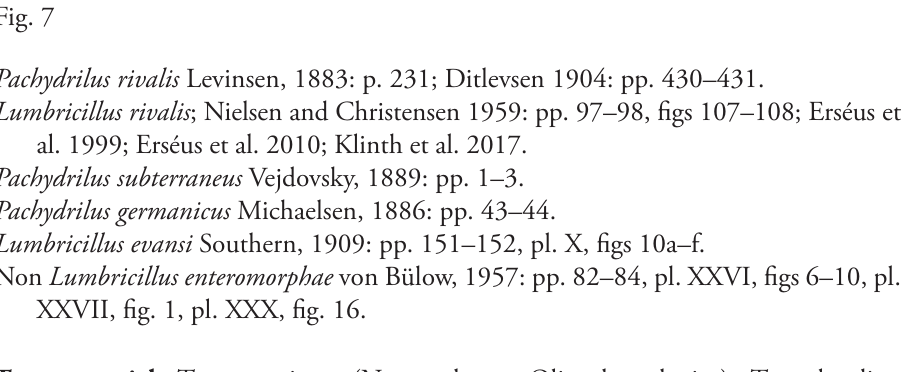
XXVII, fig. 1, pl. XXX, fig. 16. Type material. Typus amissus (Nomenclatura Oligochaetologica). Type locality: Langelinie, Denmark (Levinsen, 1883). We did not designate a neotype as we do not have material from the type